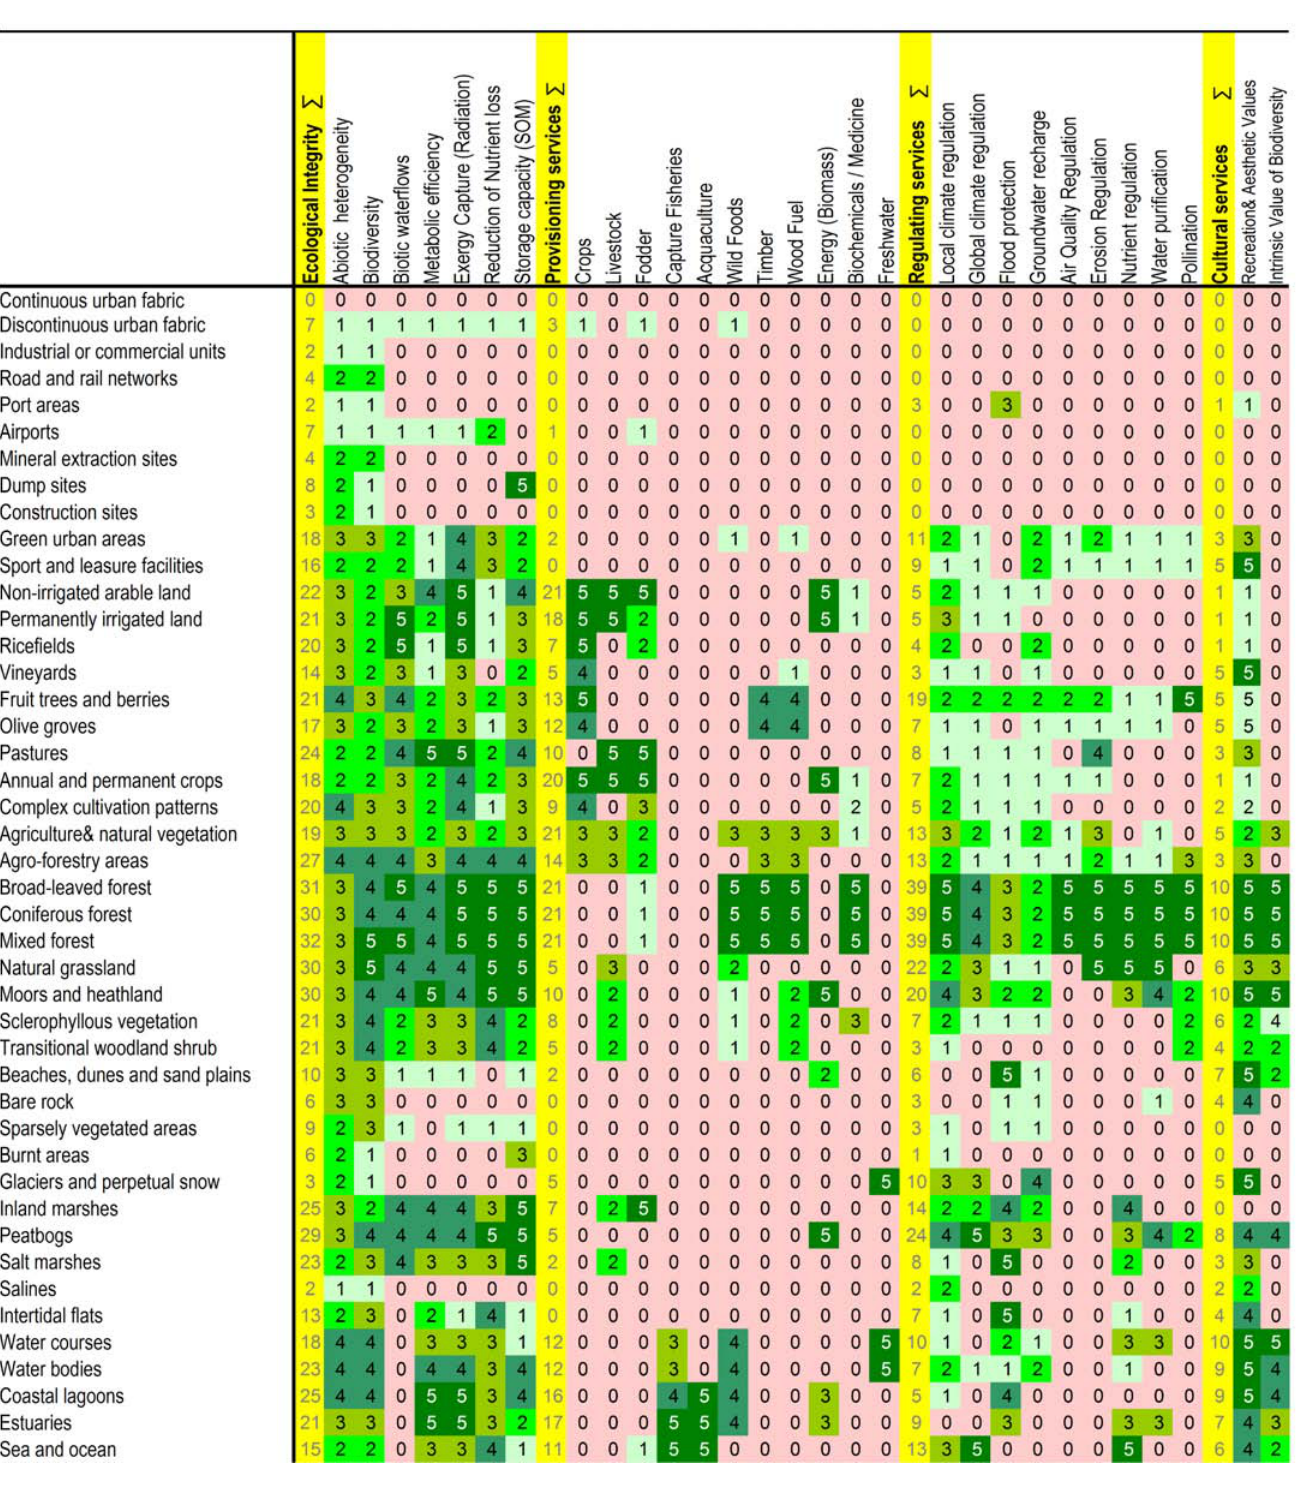
Table 1: Matrix for the assessment of the different land cover types‘ capacities to provide selected ecosystem goods and ser- vices (for definition of land cover types and ecosystem services see Appendices 1 and 2). The assessment scale reaches from 0 = rosy colour = no relevant capacity of the land cover type to provide this particular ecosystem service, 1 = grey green = low relevant capacity, 2 = light green = relevant capacity, 3 = yellow green = medium relevant capacity, 4 = blue green = high relevant capacity and 5 = dark green = very high relevant capacity. In the rows between the assessments (yellow colour), sums for the individual ecosystem services groups were